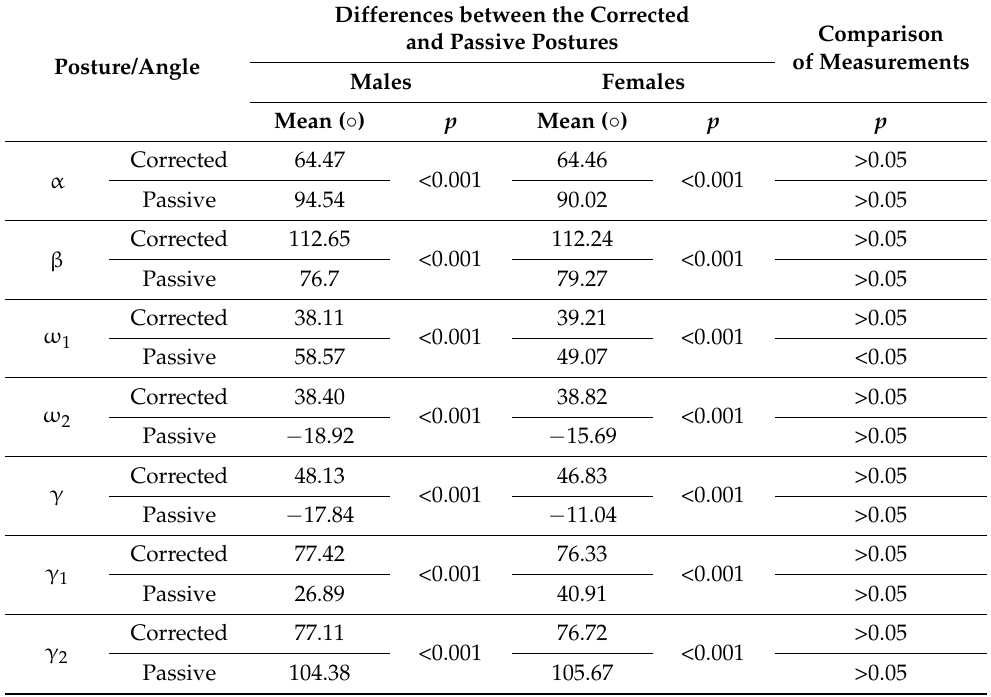
Table 3. Differences between the corrected and passive posture and comparison of measurements. Differences between the Corrected and Passive Postures Comparison of Measurements Posture/Angle Males Females Mean ( ◦ ) p Mean ( ◦ ) p p Corrected 64.47 64.46 >0.05 α <0.001 <0.001 Passive 94.54 90.02